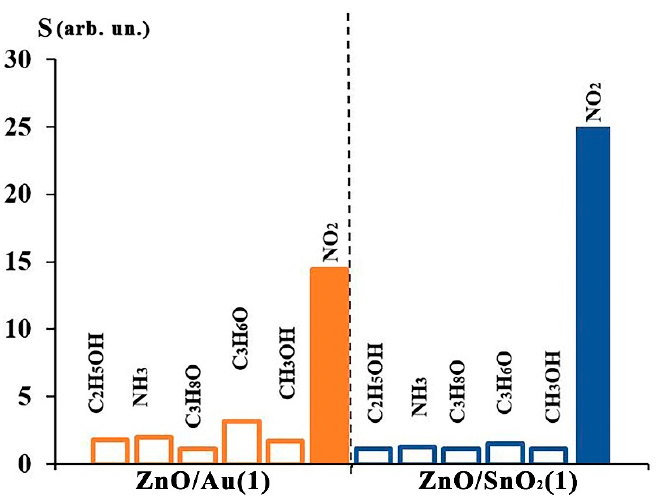
Figure 7. The chemiresistive responses of sensors based on ZnO/SnO 2 and ZnO/Au NRs upon exposure to C 2 H 5 OH, NH 3 , C 3 H 8 O, C 3 H 6 O and CH 3 OH at 10 ppm concentration at 200 °C.